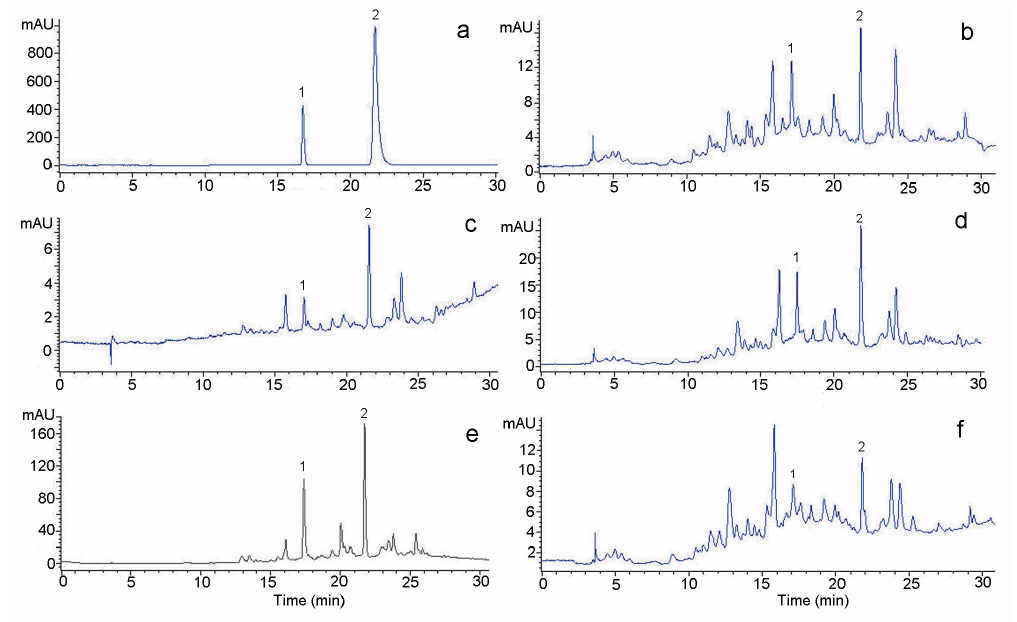
Figure 3. HPLC chromatogram (280 nm) of (a) authentic standards (1) catechin and (2) ferulic acid and (b) methanolic extract (c) n -hexane fraction (d) chloroform fraction (e) ethyl acetate fraction (f) water fraction of S . cumini